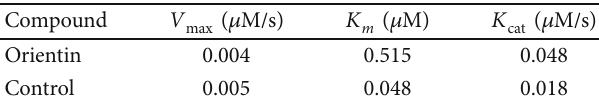
Figure 3: Lineweaver-Burk plot of orientin against PTP1B exhibiting mixed inhibitory mode. Table 6: Kinetics of inhibition of protein tyrosine phosphatase 1B by